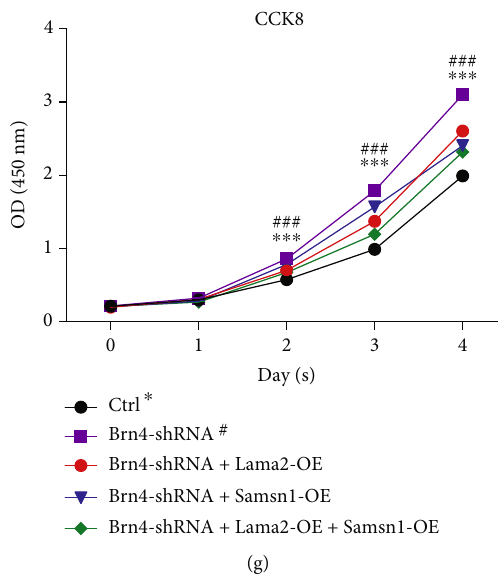
Figure 5: Lama2 and Samsn1 partially reverse the inhibitory e ff ect of Brn4 on NSCs proliferation. (a – f) Representative cell cycle distribution analyzed by fl ow cytometry for the primary hippocampal NSCs with di ff erent treatments at the same time (a – e) and quanti fi cation for NSCs in the di ff erent stages of the cell cycle (f). (g) CCK-8 assay in primary hippocampal NSCs 0, 1, 2, 3, and 4 days after lentivirus infection or plasmid transfection simultaneously. Error bars represent the mean ± SEM . n = 3 . ∗∗∗ P < 0 : 001 vs. Ctrl, ### P < 0 : 001 vs.